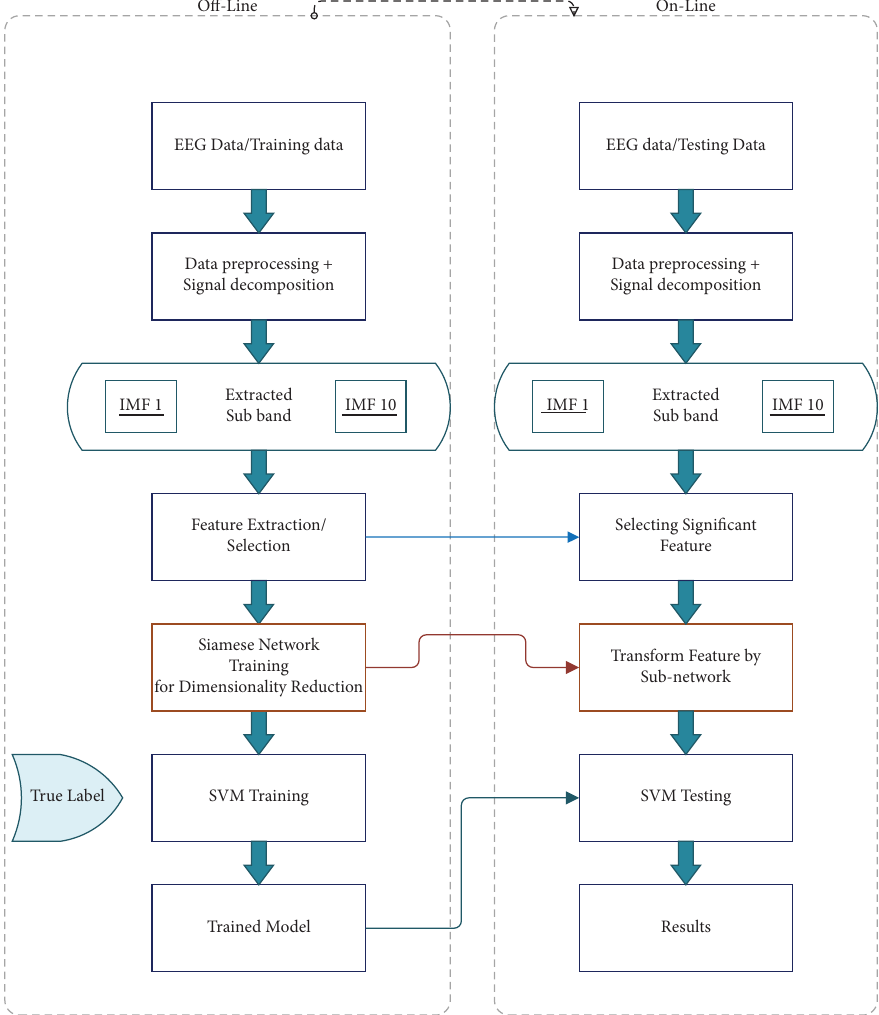
Figure 2: Block diagram of the proposed method for